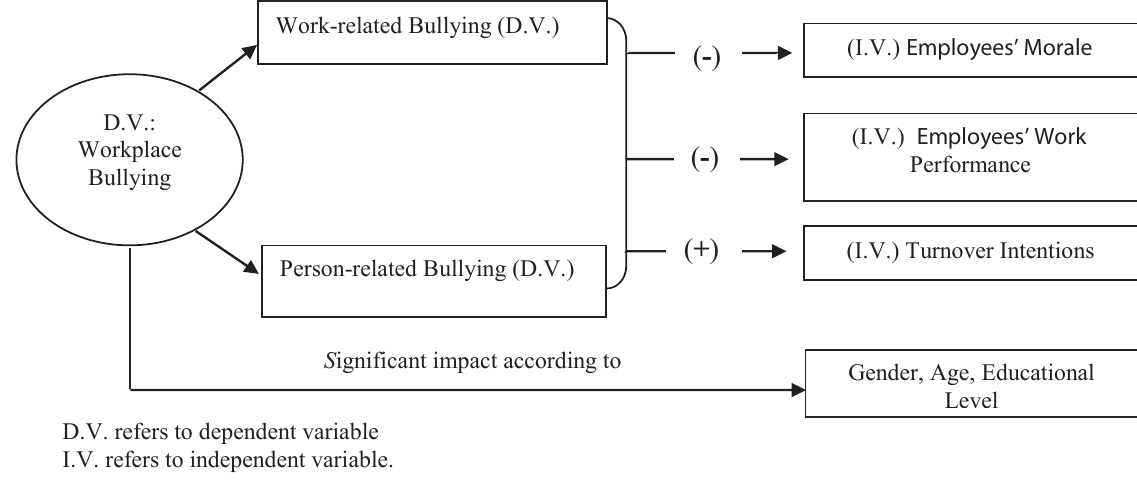
Figure 1. Hypothetical Model of the